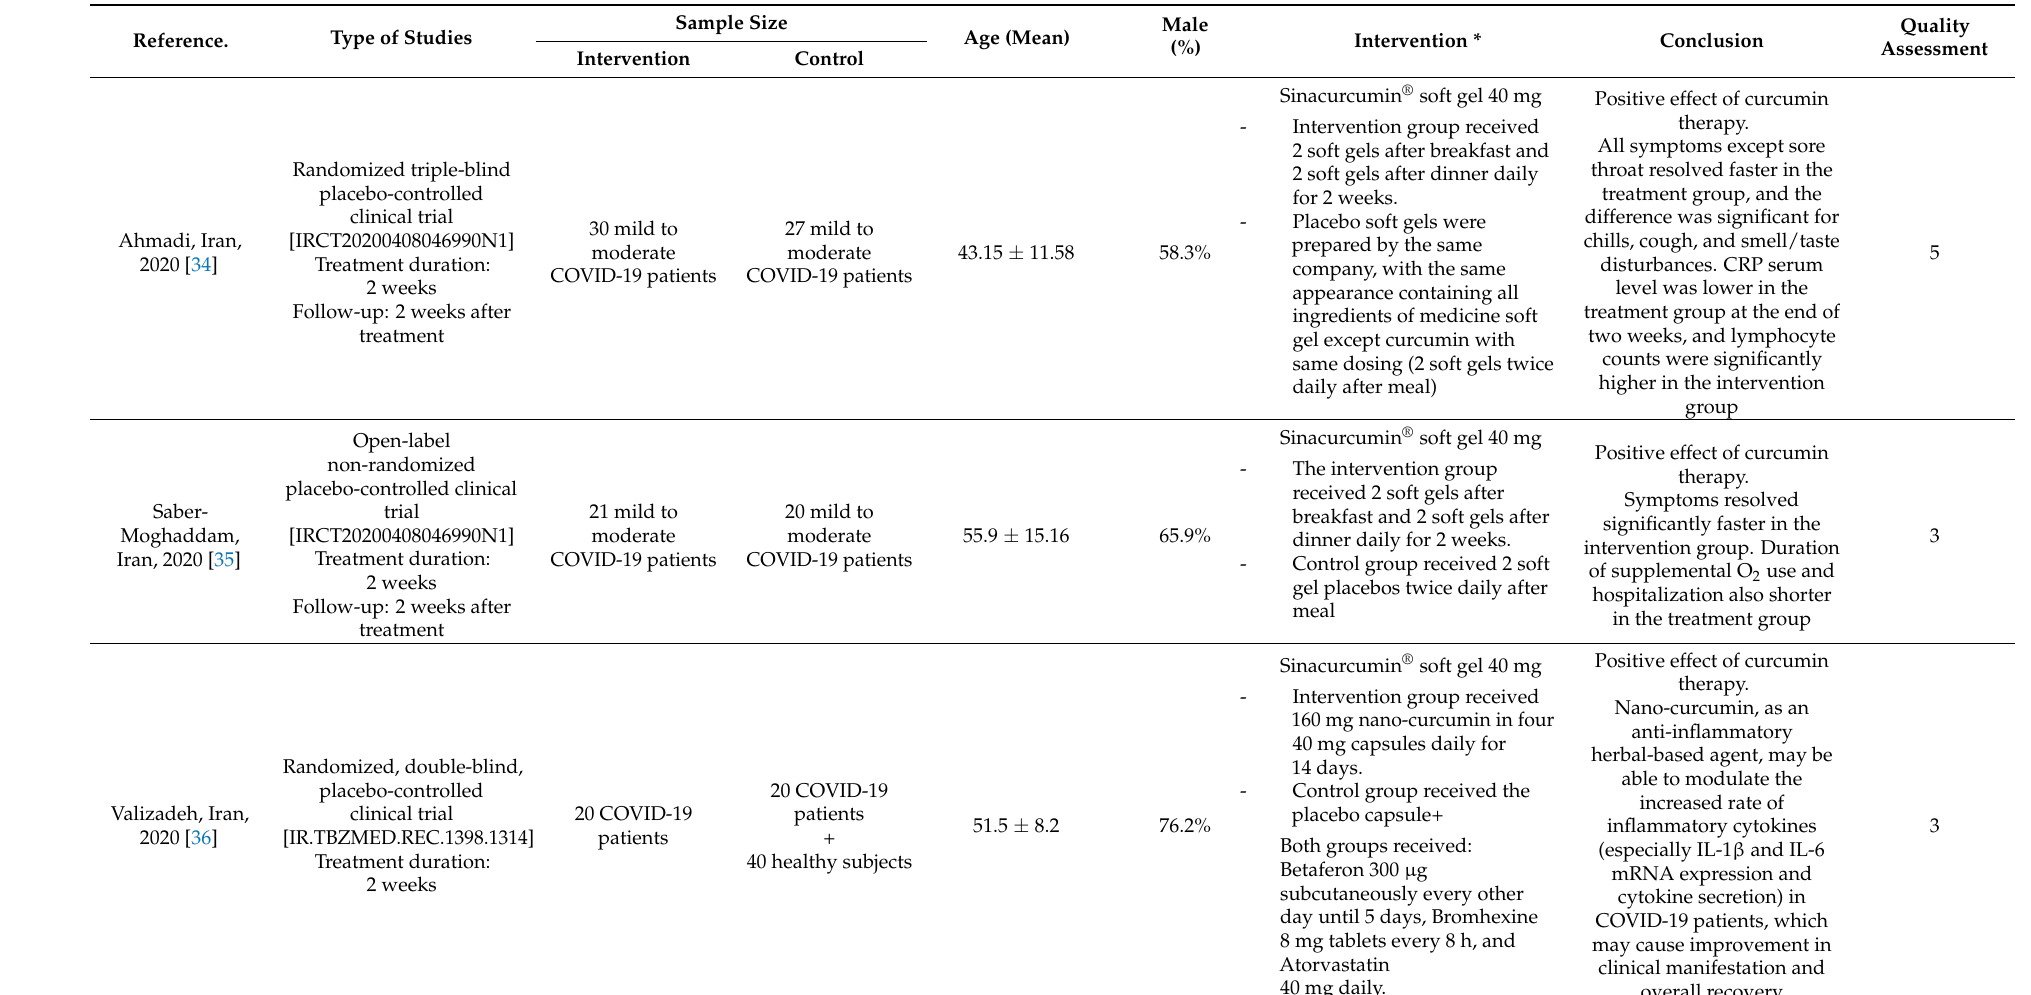
Table 1. Characteristics of the studies